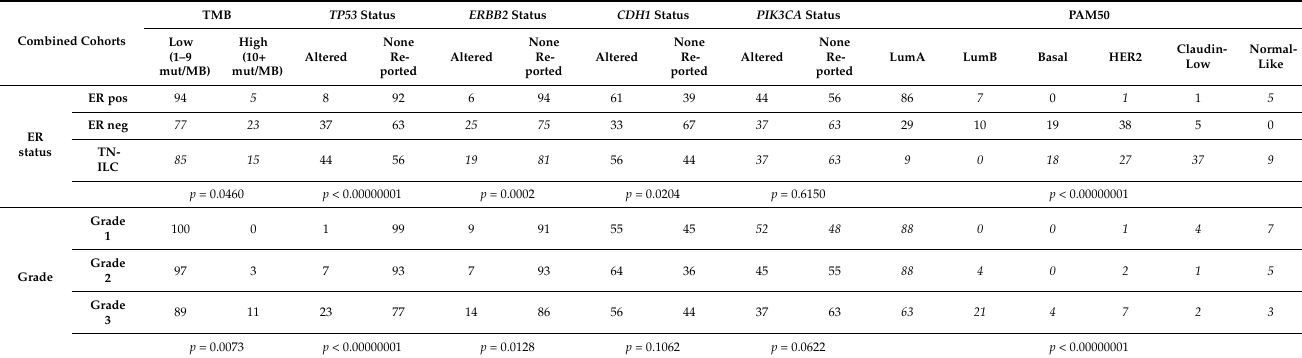
Table 2. Contingency table of relationship between ILC molecular features and grade across the combined cohort.